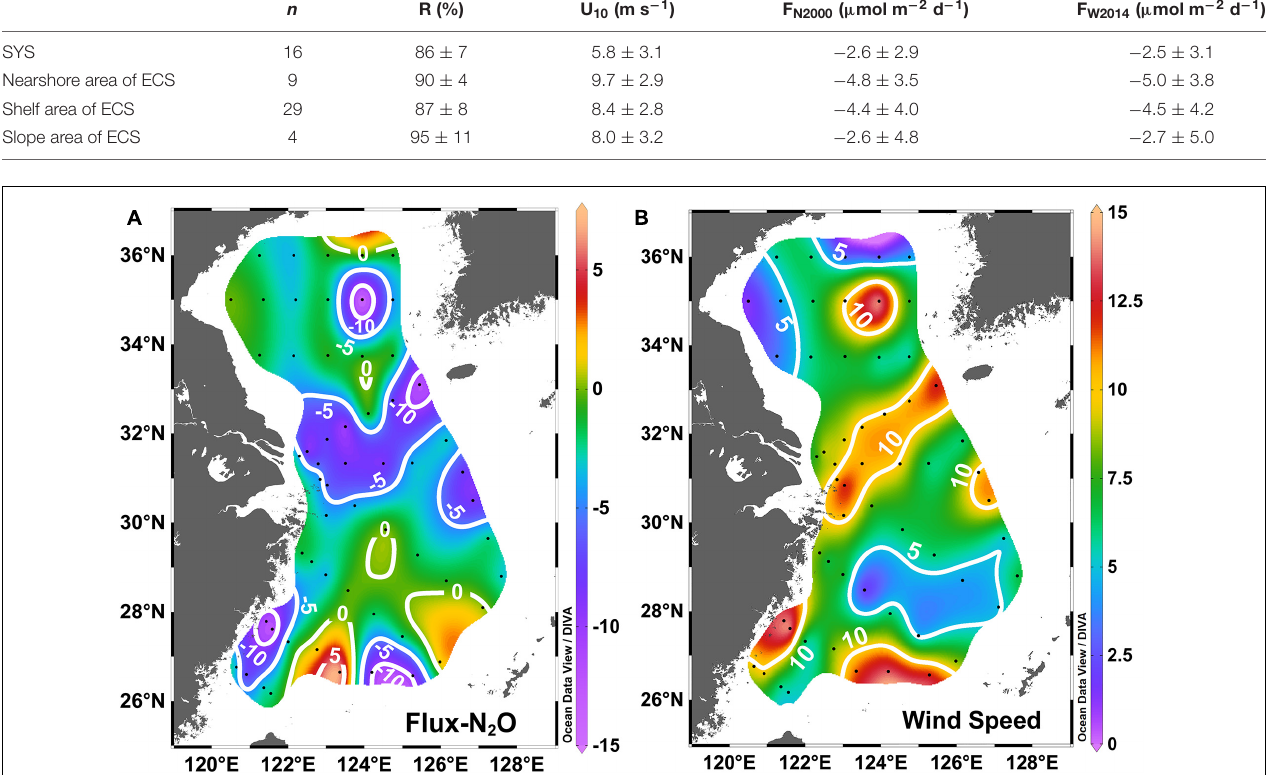
FIGURE 9 | (A) The sea-to-air flux of N 2 O ( µ mol m − 2 d − 1 ) and (B) wind speed (m s − 1 ) in the SYS and the ECS during early spring.